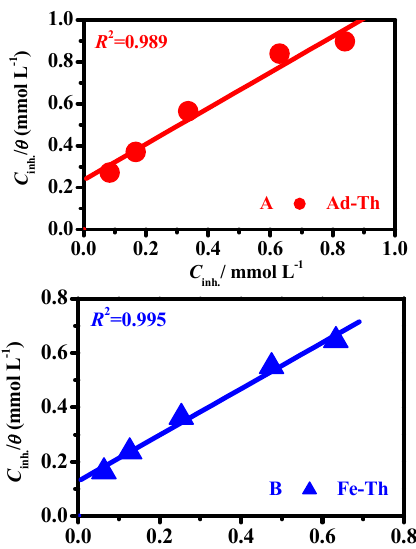
Figure 6. Langmuir adsorption diagram for ( A ) Ad-Th and ( B ) Fe-Th on C-steel in molar HCl medium at 50 °C.